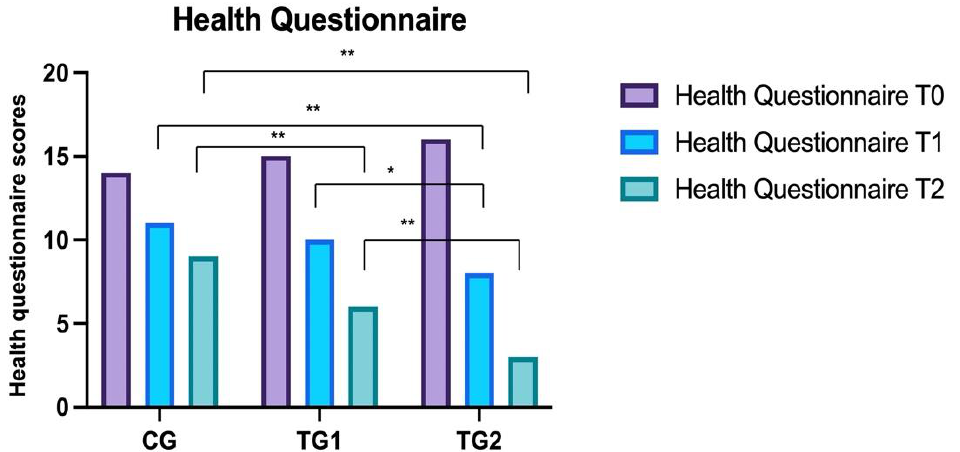
Figure 1. Comparison of the health questionnaire results between the three groups. Control Groups (CG), Treatment Group 1 (TG1), and Treatment Group 2 (TG2). Standard deviation “I”. The asterisk “**” indicates p < 0.01, “*” p < 0.05.